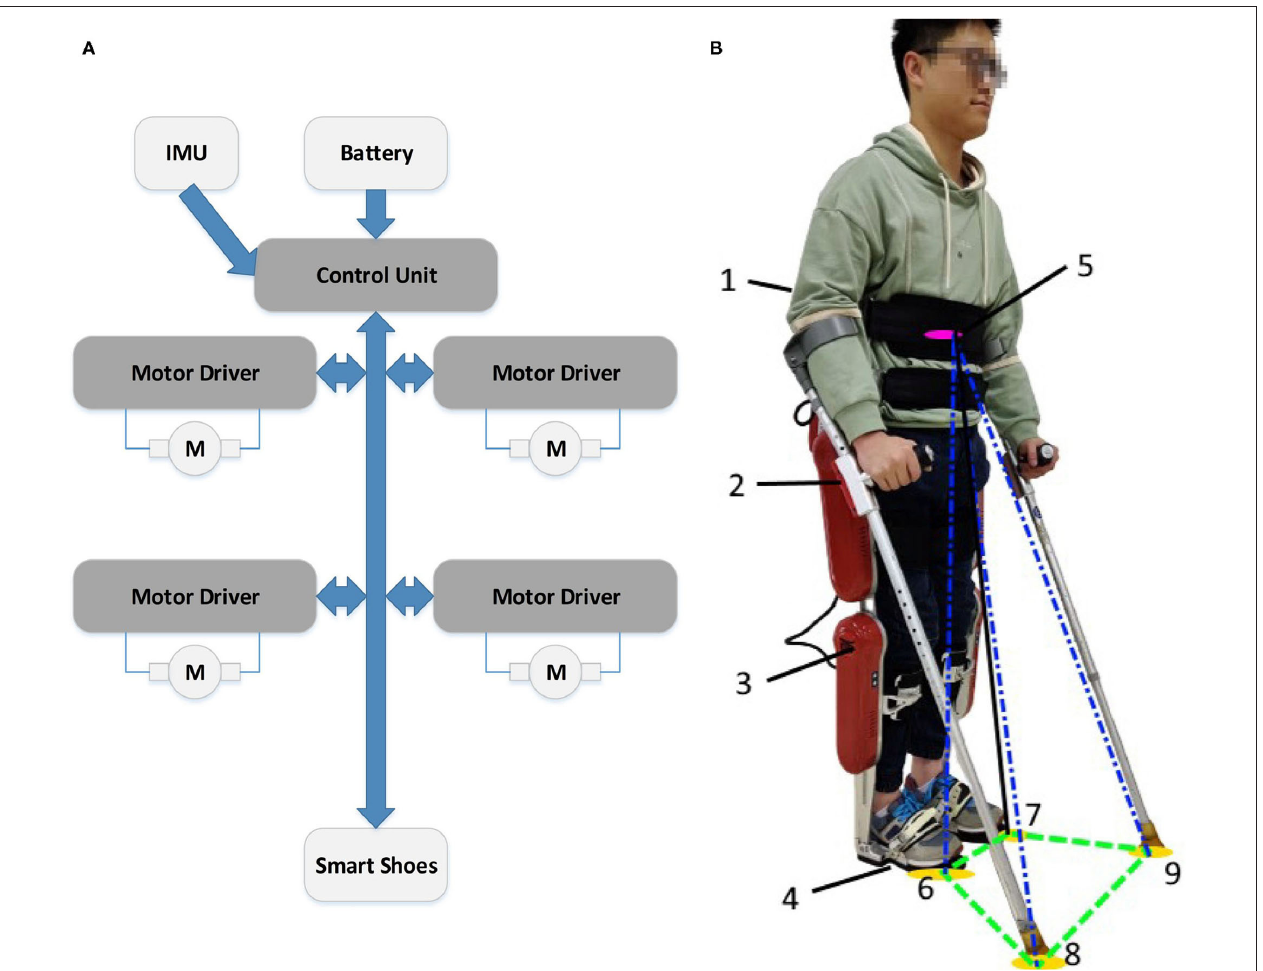
FIGURE 11 | (A) is the basic functional diagram of the exoskeleton, and (B) is the human-exoskeleton system diagram. In the human-exoskeleton system, the pilot could stand like this with the exoskeleton. To collect the system’s safety status, a lot of sensors are installed in the exoskeleton. 1: An Inertial Measurement Unit (IMU) in the backpack of the exoskeleton to sense the attitude and velocity of the pilot’s upper body to estimate the position of the system’s XCoM labeled as 5. 2: The IMU and pressure sensor to sense whether the crutch is in contact with the ground and the corresponding posture of the crutches, which could help to calculate part of BoS labeled as 8 and 9. 3: The angle encoder module to get the joint angles of the exoskeleton to get the position according to the forward kinematics module. 4: The pressure sensor under the foot to detect whether the foot touches the ground and estimate part of BoS labeled as 6 and